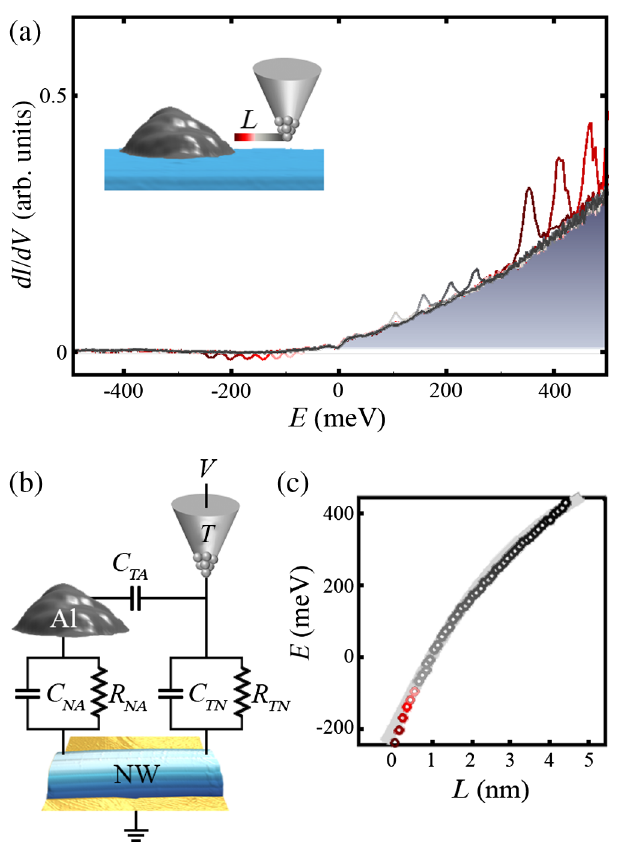
FIG. 9. (a) dI=dV curves at varying distance from the Al island, highlighting the resonance peaks. The red to gray color scale corresponds to the distance from the right boundary of the island, as illustrated in the topography inset. The background signal of the InAs spectrum is marked with solid blue. (b) A diagram of the corresponding circuit when the tip descends from the Al island and becomes an effective gate electrode. (c) A trace following the energy-distance dispersion of the resonance (circles) with a power-law fit (light